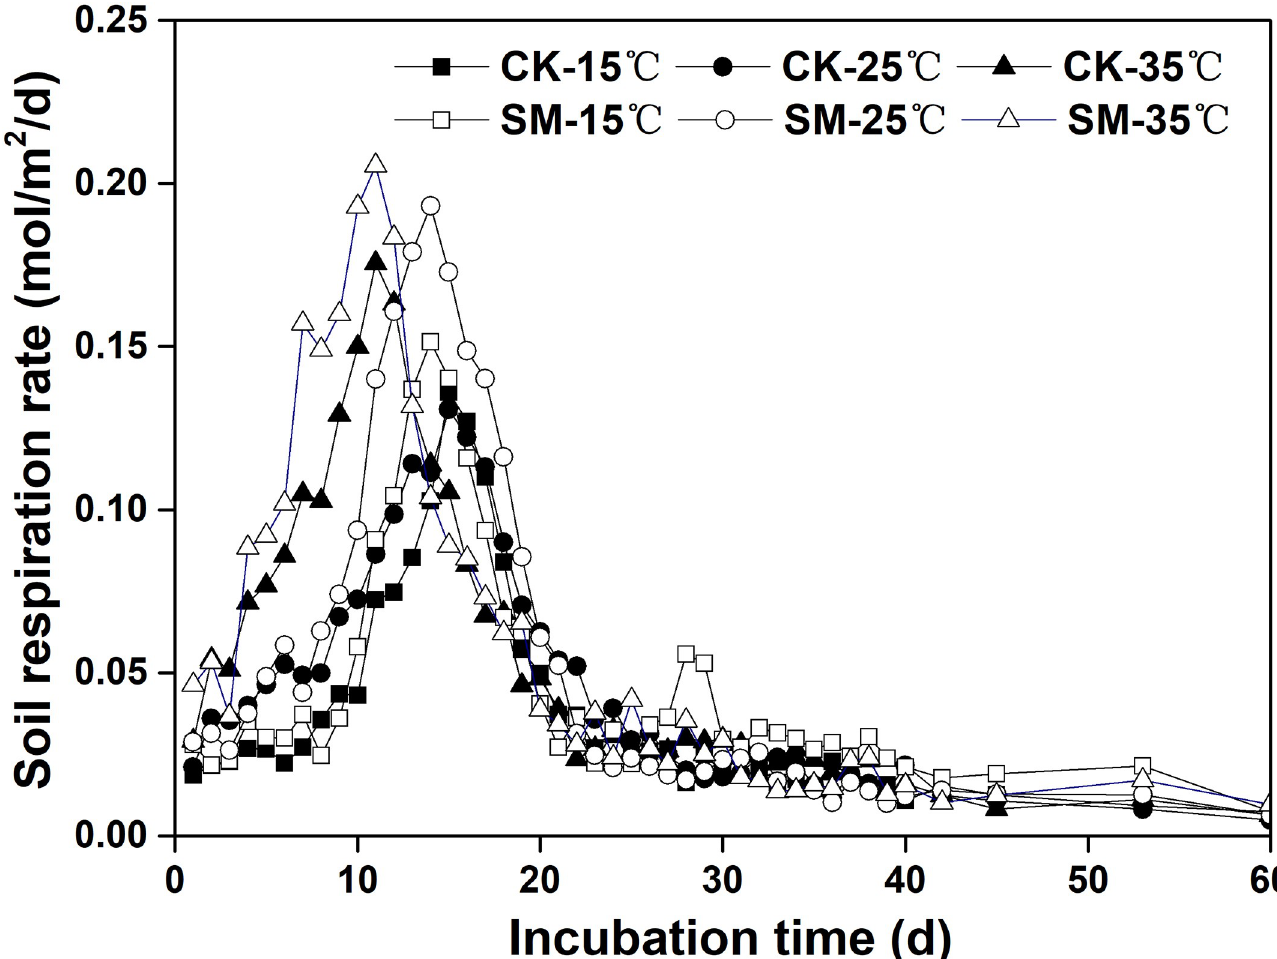
Fig 1. Soil respiration rate under different mulching methods and incubation temperatures. CK: no mulching; SM: straw mulching.